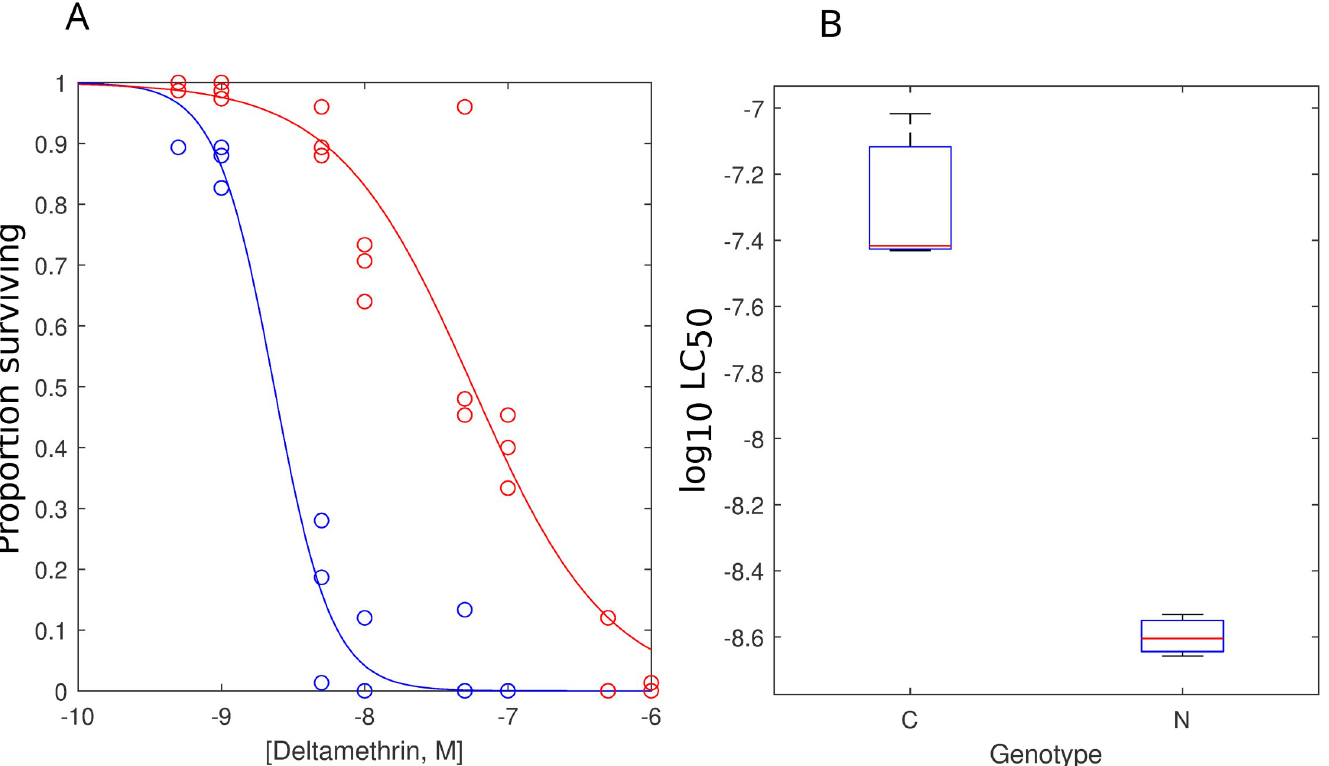
Fig 4. The application of the standard WHO larval assay to detect deltamethrin resistance in Ae . aegypti . Deltamethrin was tested over a range between 5.0 x 10 − 10 M to 1.0 x 10 − 6 M. (A) The concentration-response curves are given for the wild-type New Orleans strain (blue) and the Deltamethrin-resistant Cayman strain (red). s estimated from fitting the curves in A to a Sigmoid curve. The WHO assay yielded LC 50 s of 8.60 ± 0.04 (2.5 nM) and 7.29 ± 0.14 (51.3 nM) for (B) The fitted P IC 50 New Orleans and Cayman respectively (2-tailed, independent t-test, T(4) = -3.9, P = 0.0). Each point in (B) represents the mean of 3 (WHO) separate experiments and error bars indicate the standard error of the